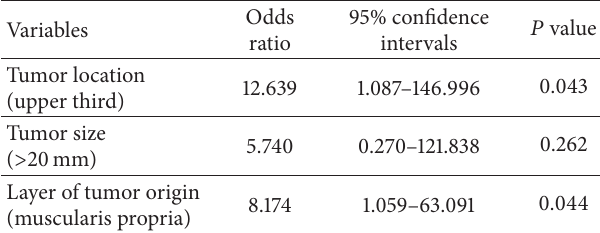
Table 4: Multivariate analyses for predictive factors of incomplete resection with endoscopic submucosal dissection for gastric subep- ithelial